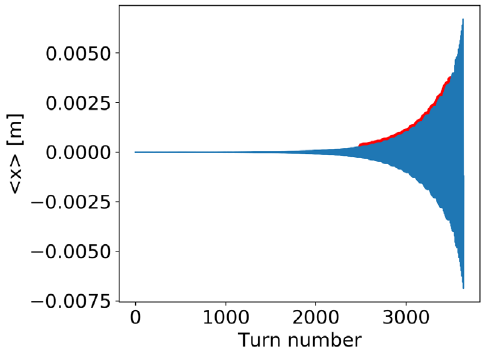
FIG. 13. Bunch shape due to the potential well distortion at zero current and at N inductive impedance (left) and BBR (right).